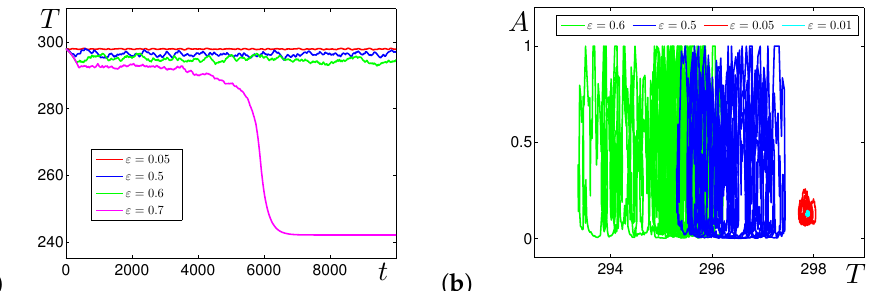
Figure 4. Stochastic system (2), (3) for γ = 0.1, σ 1 = 1, σ 2 = 0: ( a ) time series, ( b ) phase